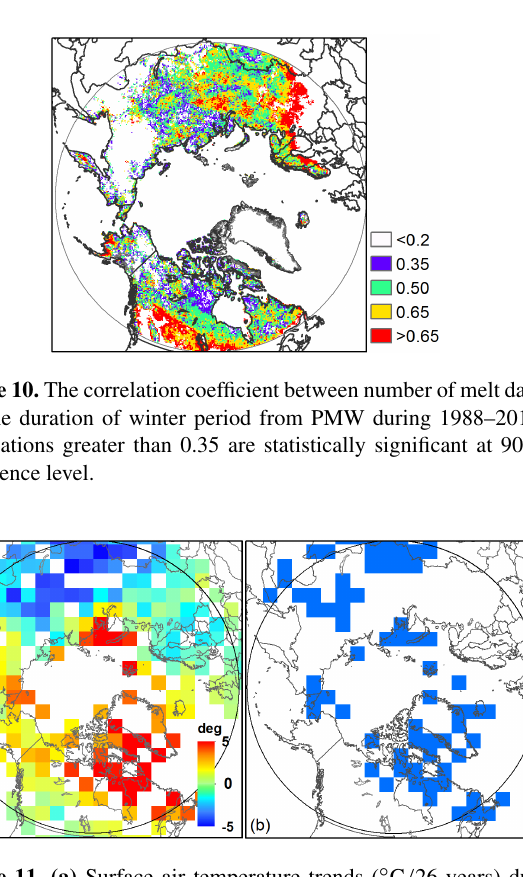
Figure 11. (a) Surface air temperature trends ( ◦ C / 26 years) dur- ing the winter season (DJF) for north of 50 ◦ N land areas from CRUTem4 over the period 1988–2013, (b) grid cells with trends statistically significant at the 90% level in (a)